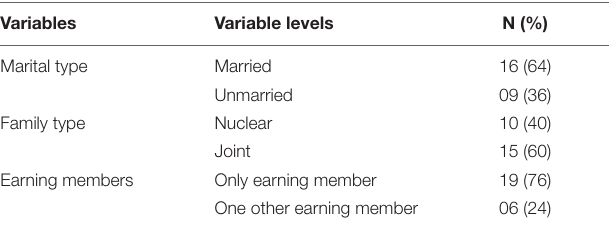
TABLE 1 | Demographic characteristics of the study